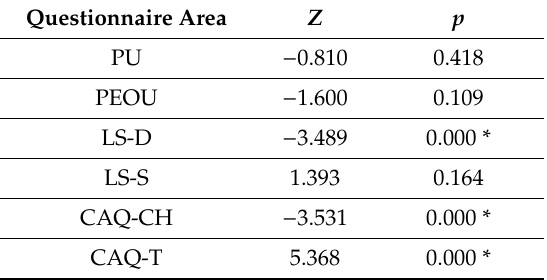
Table 1. The results of Wilcoxon’s two-sample test. Questionnaire Area